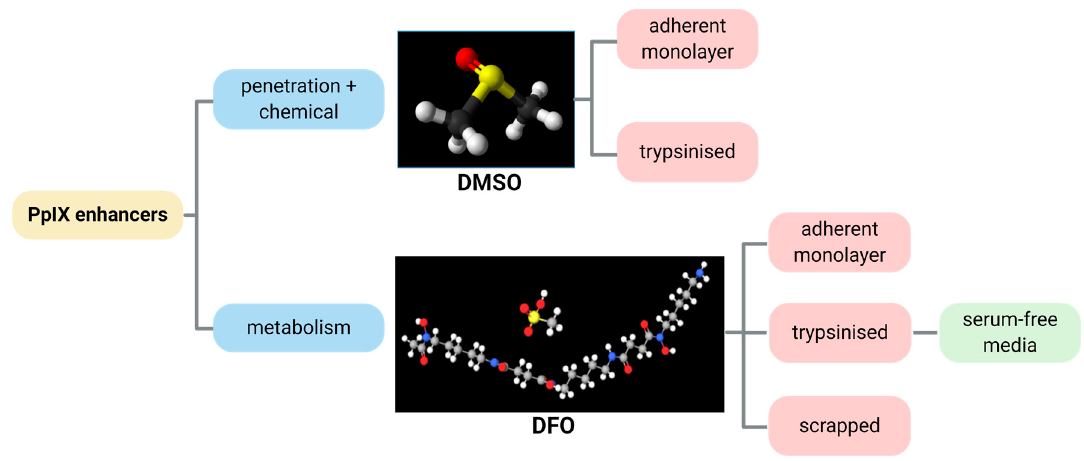
Figure 2. Illustrative diagram showing the process approach to improve the HAL mediated PpIX fluorescence by the chemicals DMSO and DFO.